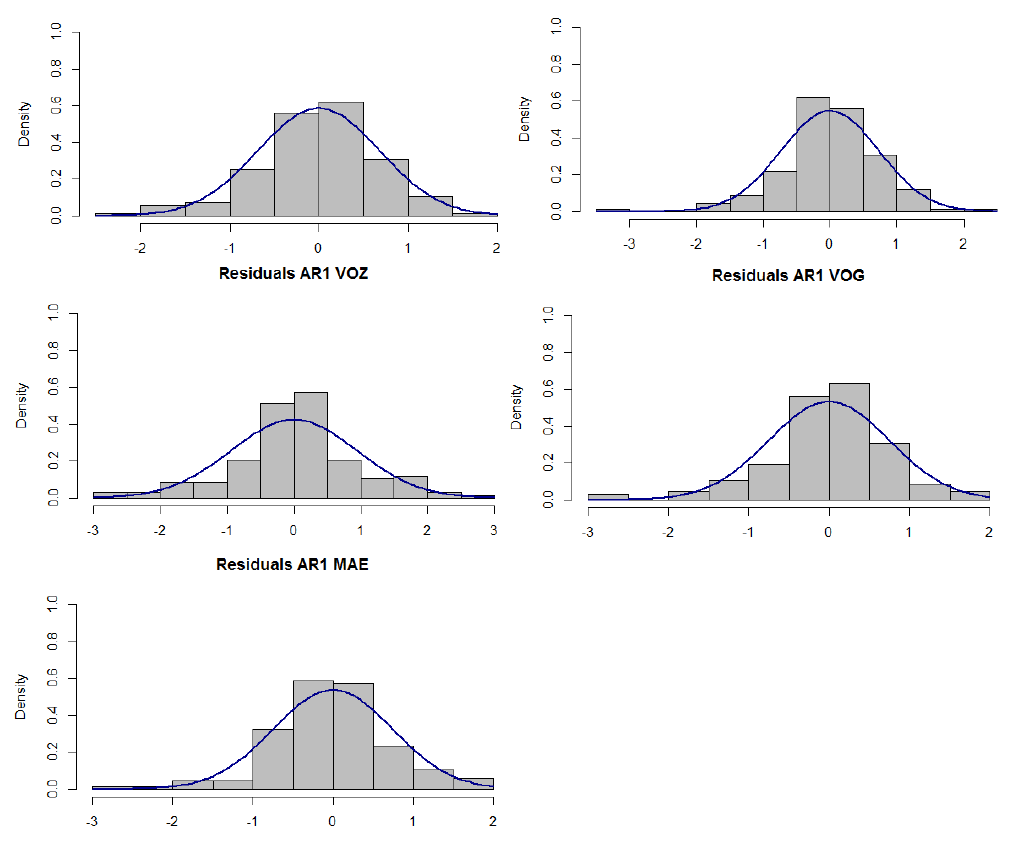
Figure 3. Histogram of residual series for the model MII (2)–(3) with the adjusted normal